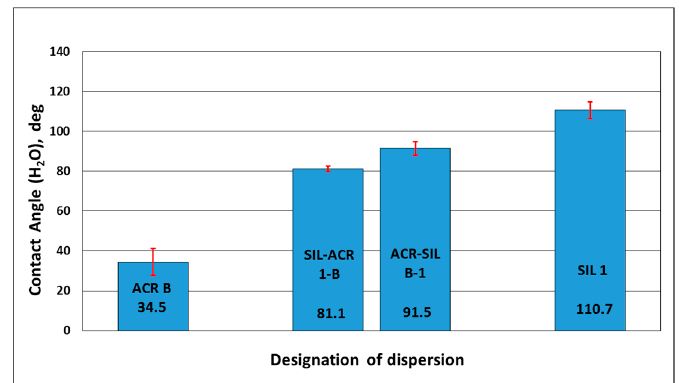
Figure 10. Comparison of contact angle values determined for coatings obtained from starting SIL and ACR dispersions and corresponding hybrid SIL-ACR and ACR-SIL dispersions having the same composition of ACR and SIL parts. Contact angle determined for starting acrylic/styrene copolymer dispersion (ACR B) is also shown.